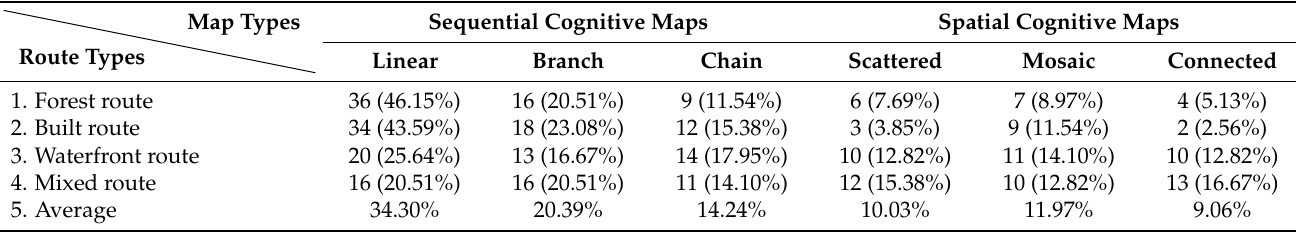
Table 3. Statistics of the cognitive maps.